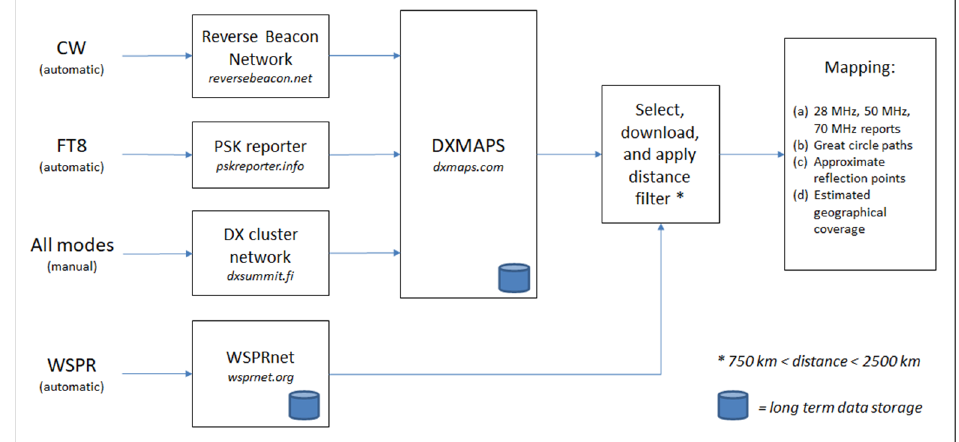
Figure 1. Overview of the approach to the collection, filtering, and mapping of amateur radio reception reports. * The distance filter selects for path lengths between 750 km and 2500 km (see text).